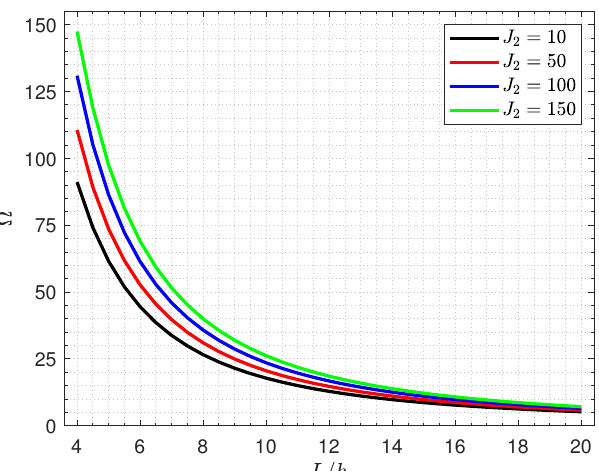
Figure 3. Effects of the Winkler elastic foundation parameter J 1 on the frequency of the nanocomposite piezoelectromagnetic plate (Type B).